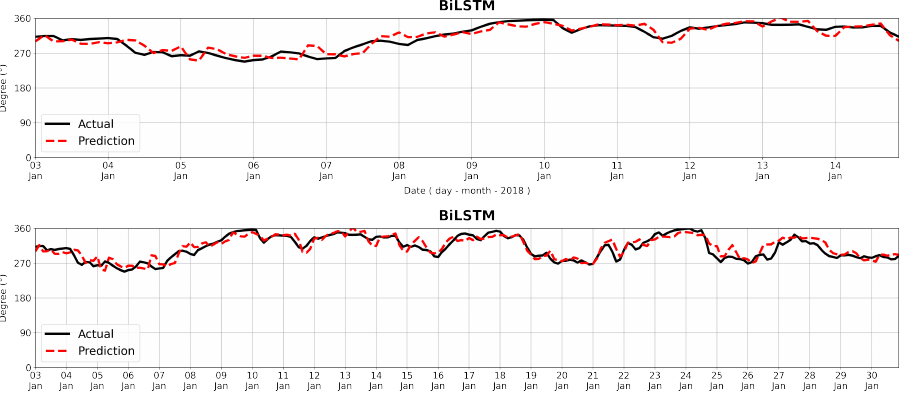
Figure 19. Results of the prediction of the mean wave direction for 14 (upper plot) and 30 days (lower plot) ahead using the BiLSTM model with 15 years of training data.